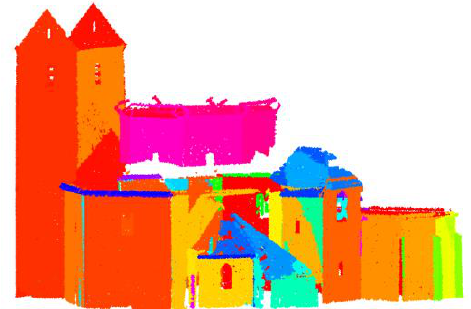
Figure 7. Segmentation results obtained for the interior of the church; (a) automatically ( st =10 cm); (b) manually After segmentation, the points composing the contours of the segments must be extracted. In the case of cylinders or cones,